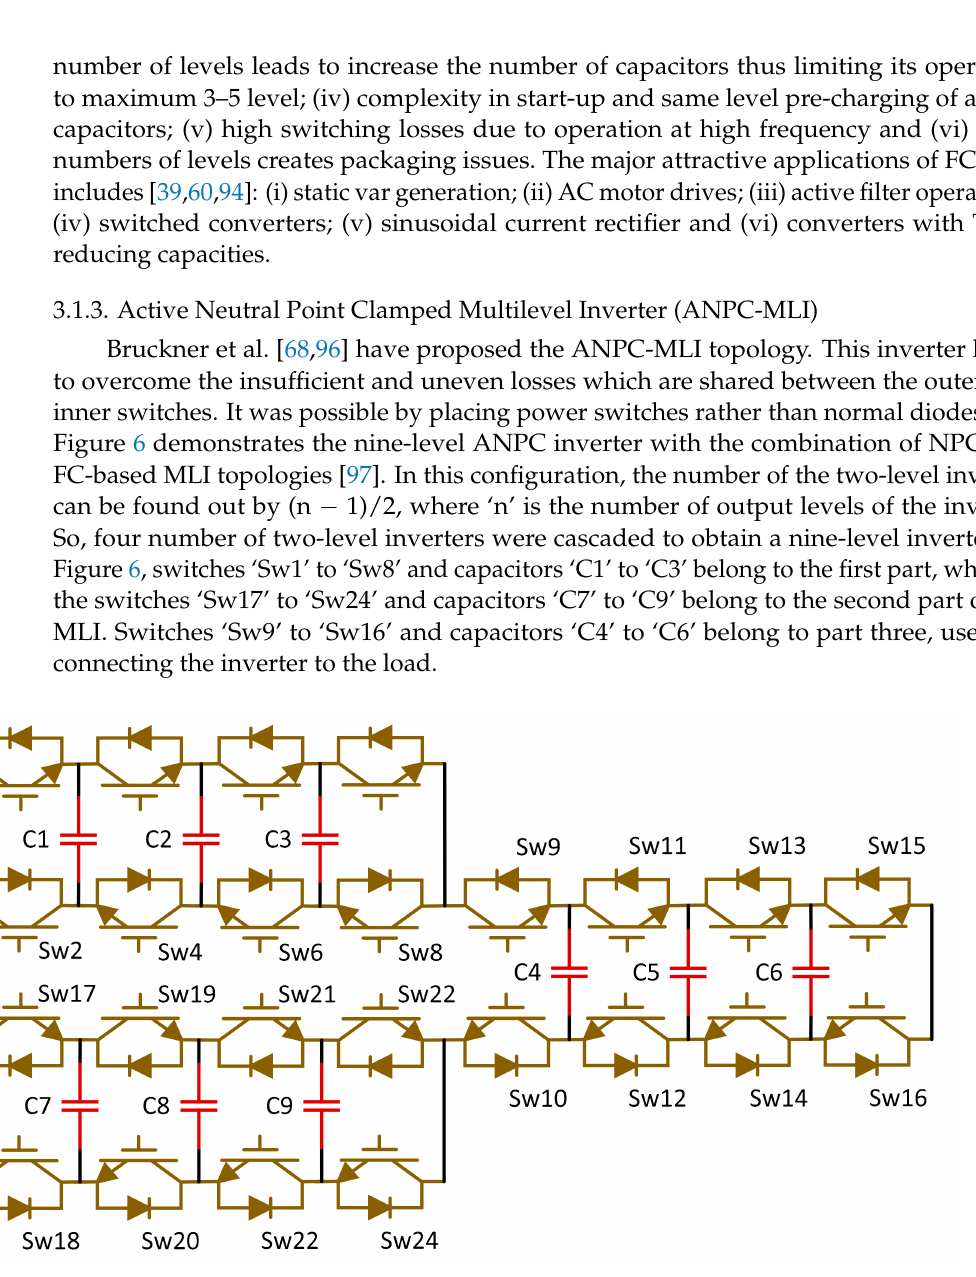
Figure 6. Topology of active neutral point clamped multilevel